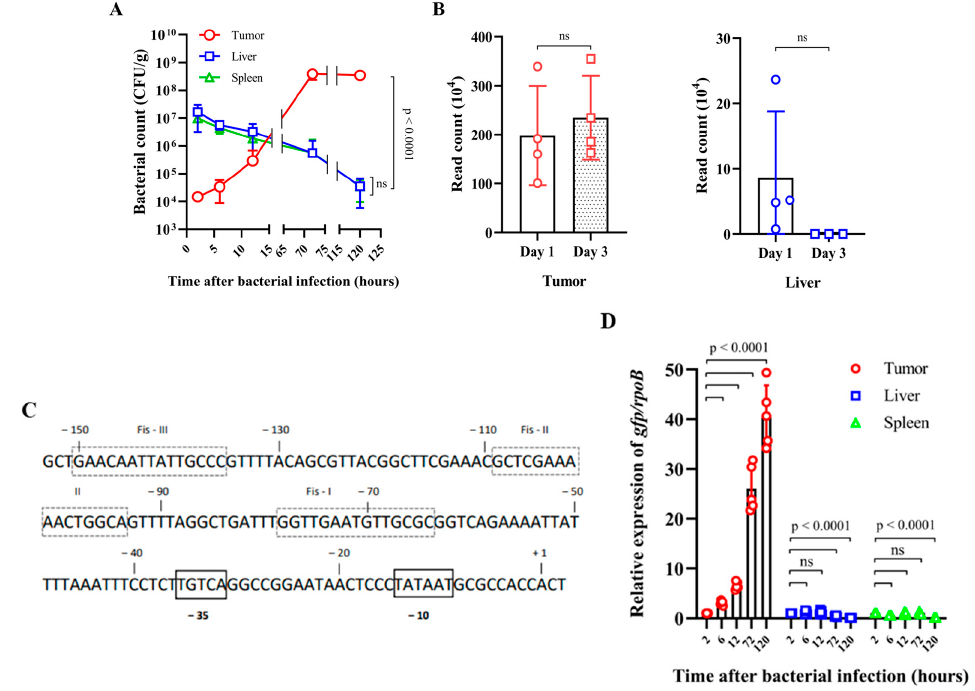
Figure 1. Fate of E. coli injected into tumor-bearing mice. BALB/c mice grafted with CT26 colon carcinoma cells received intravenous injection of Escherichia coli MG1655 ( n = 4 per group, 1 × 10 8 CFU/mouse) when tumor volumes reached 130–150 mm 3 . ( A ) At the indicated times after the injec- tion, tumors, livers, and spleens were extracted to determine bacterial counts (CFU/gram). ( B ) RNA sequencing analysis was performed to determine the expression pro fi le of the rrnB operon (number of reads) (NC_000913.3) in E. coli residing in tumors and livers at 1 and 3 days postinjection (dpi). ( C ) The rrnB P1 promoter sequence with three Fis -binding sites (I–III) in the upstream activation region. ( D ) E. coli MG1655 carrying prrnBP1-gfpOVA (EMP4002) was administered intravenously to CT26-grafted mice ( n = 5/group, 1 × 10 8 CFU/mouse). To monitor rrnB P1 promoter activities in vivo, the levels of gfp expression in tumors, livers, and spleens at each time point were determined by quantitative real-time PCR. The E. coli rpoB gene was used as a reference, and data were normal- ized by the 2 −ΔΔ Ct method. All data are expressed as the mean ± SD. p -values indicate di ff erences between groups (unpaired Student’s t -tests; ns: not signi fi cant).